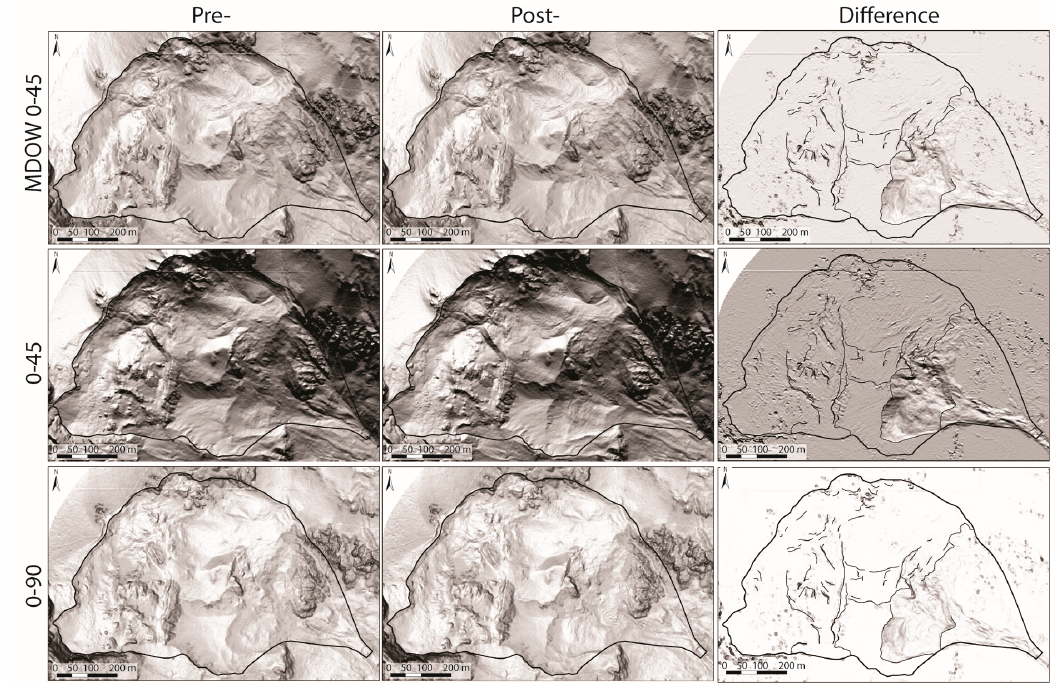
Figure 9. Pre- and post-hillshades obtained by simulating illumination from the north (0-) with altitude angles of 45° and 90°. The MDOW hill shade was obtained by simulating the primary illumination from the north with an altitude angle of 45° (see the procedure in the text). A–G localize the areas affected by the main morphological changes. The black lines in the difference maps highlight the gravity-related forms (e.g., minor crowns, lithostructural and morphological scarps, counterscarps, crests, and trenches).